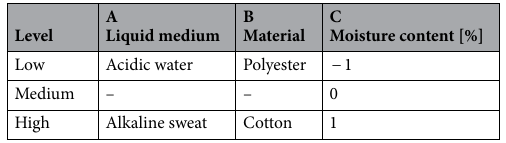
Table 3. Factors and their levels.